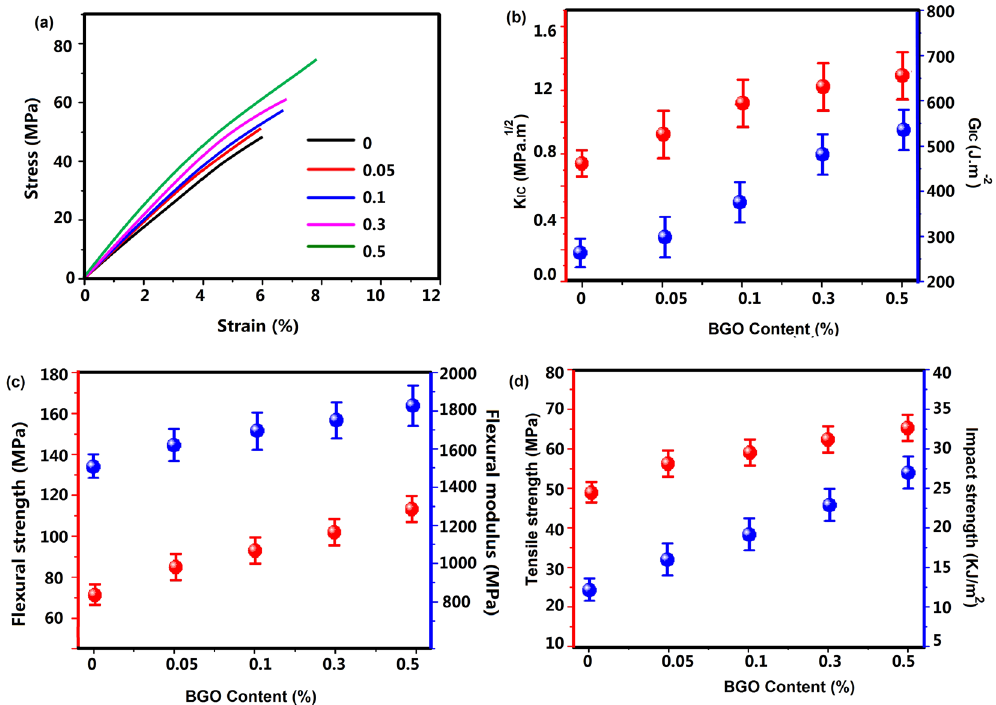
Figure 4. Mechanical and thermal properties of bGO/BFDE composites with various weight fractions of bGO: ( a ) Tensile strength, ( b ) fracture toughness, ( c ) flexural modulus and ultimate flexural strength, and ( d ) impact strength.